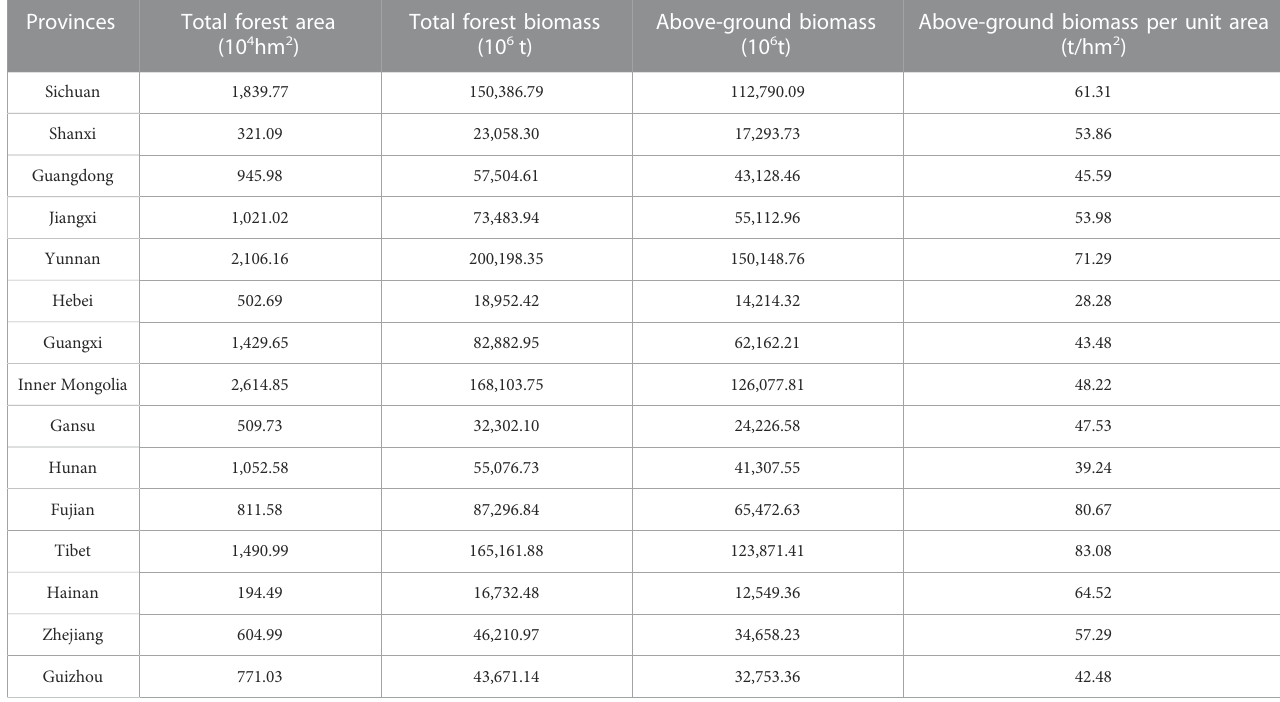
Source:The fi rsttwocolumnsofdataarefrom ChinaForestResourcesReport2014-2018 ,ChinaForestryPress,20195);thethirdcolumnrepresentstheabove-groundbiomass,accountingfor75%of the total biomass; and the fourth column represents the above-ground biomass per unit area.